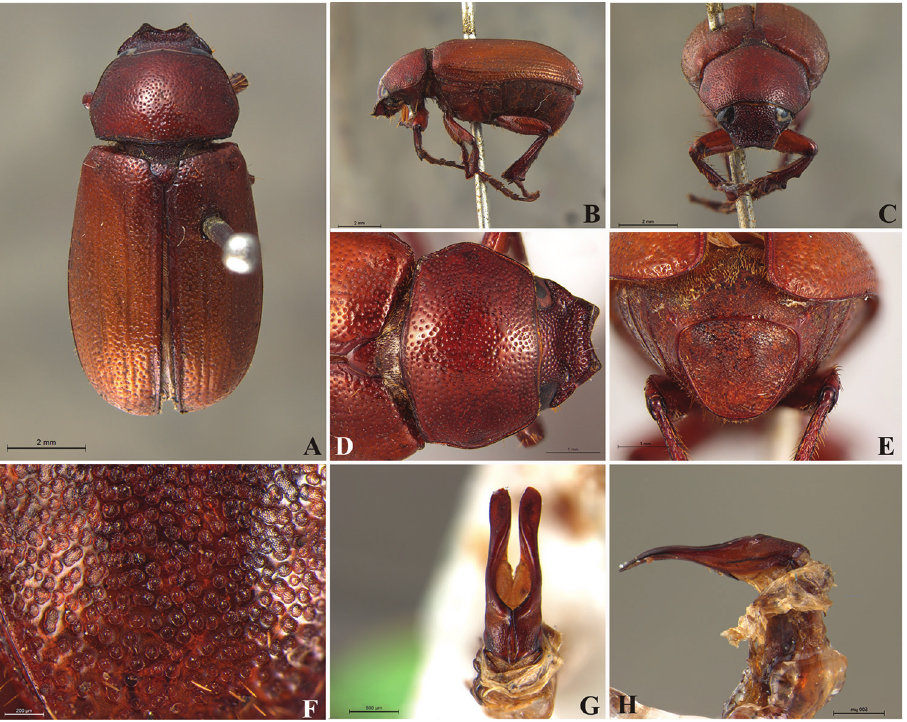
Figure 71. Liogenys santaecrucis Blanchard. A Dorsal view B Lateral view C Frontal view D Clypeus and pronotum E Pygidium F Reticulate punctures G Parameres, dorsal view H Parameres, lateral view.